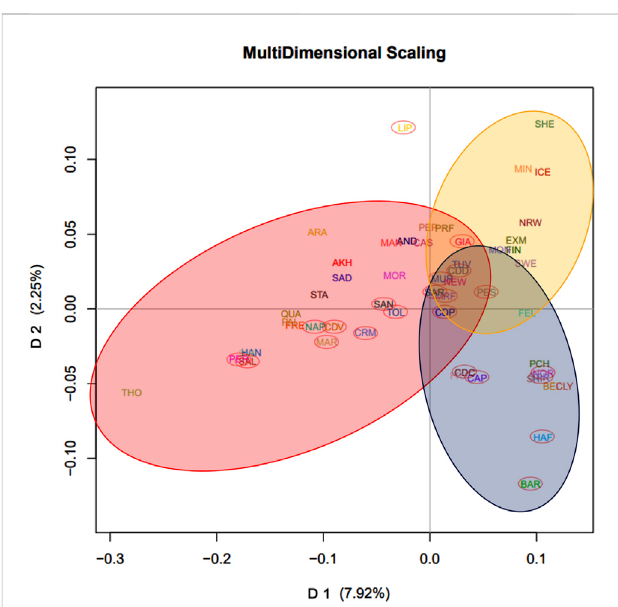
FIGURE 2 MDSplotsofaveragecoordinatesofdimension1(D1)and2(D2)for the International dataset. D1 re fl ects the warmblood quantity while D2 discriminates ponies. Three clusters were highlighted: warmblood horses, circled in red, coldblood horses, circled in blue, and ponies, circledinyellow.Italianbreedswerealsohighlightedforclaritywithared